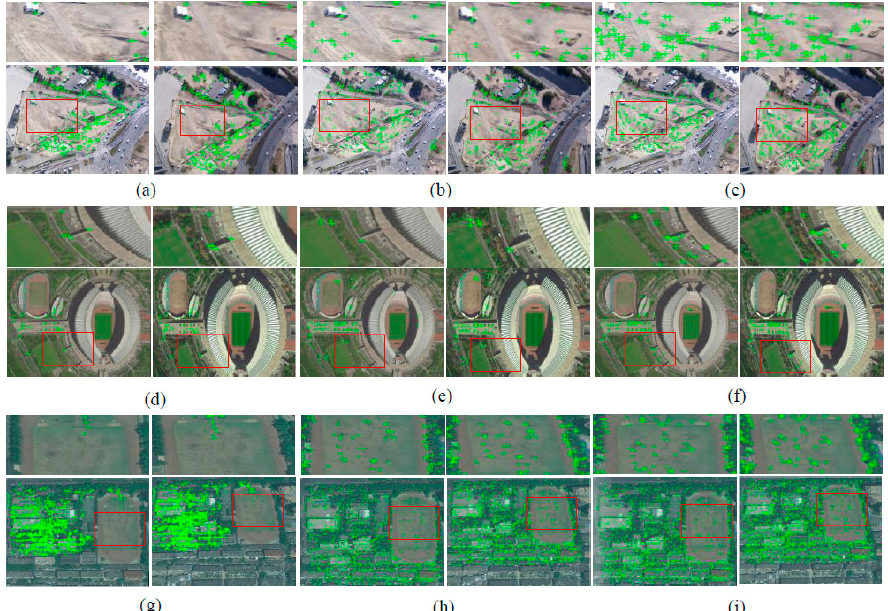
ISPRS Int. J. Geo-Inf. 2023 , 12 , x FOR PEER REVIEW 12 of 17 Figure 9. Matching results of the three methods tested on aerial stereo images HK1–3. ( a , d , g ) tested on ASIFT. ( b , e , h ) tested on Brown-AffNet. ( c , f , i ) tested on SJRS-AffNet.